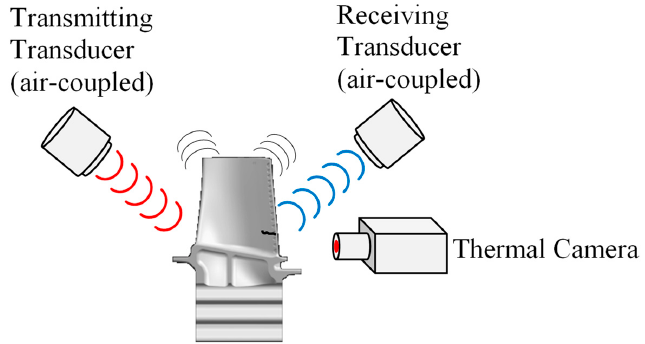
Figure 17. Thermosonic measurements with air-coupled transducer on a turbine blade.